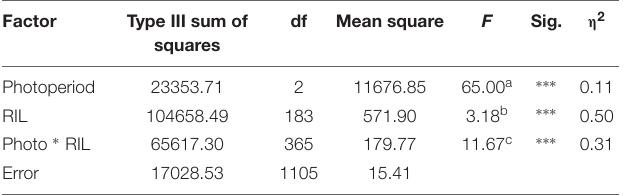
TABLE 2 | Analysis of variance of the RIL population flowering time differences in the three photoperiod regimes, with Photoperiod (fixed) and RIL genotype